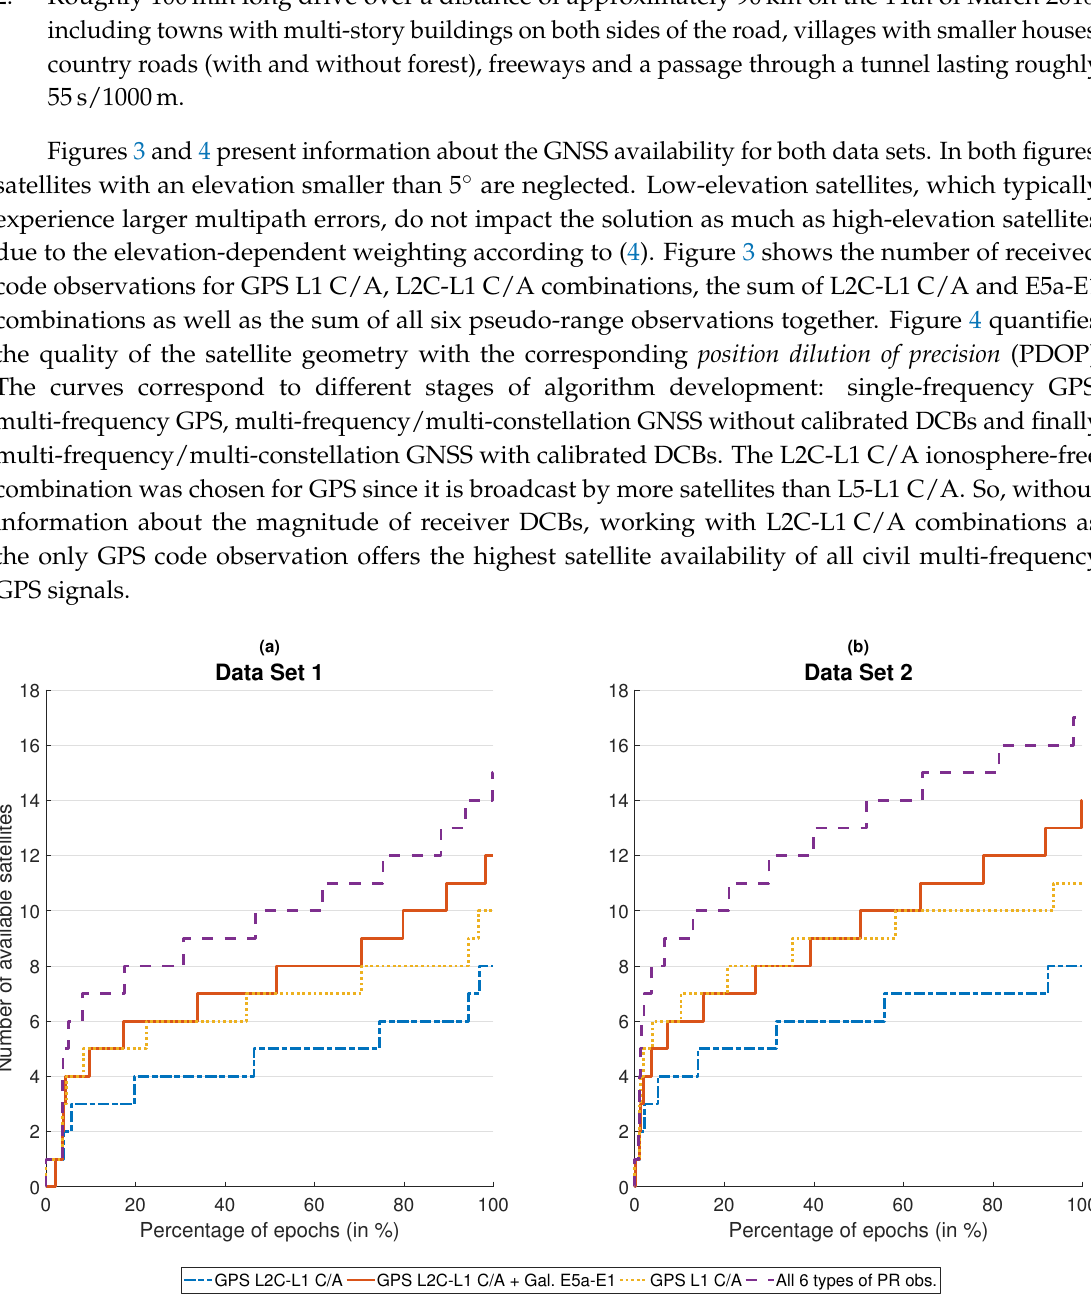
Figure 3. Percentage of GNSS measurement epochs in which no more than the indicated number of satellites was